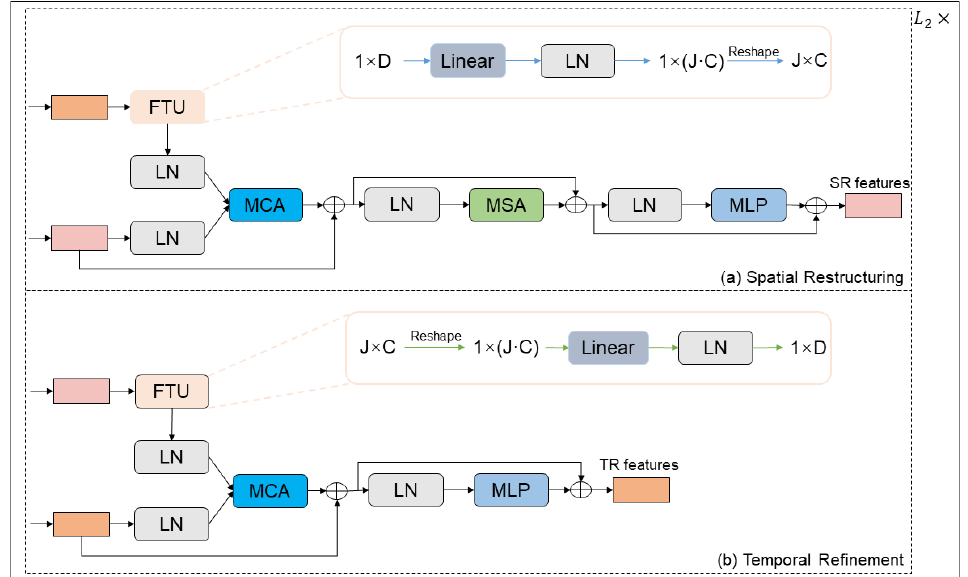
Figure 4. Cross-Domain Interaction. ( a ) The Spatial Reconstruction (SR) block injects the tempo- ral features into the spatial domain after transformation to adjust the spatial structure. ( b ) The Temporal Refinement (TR) block receives the reconstructed spatial features to further refine the temporal